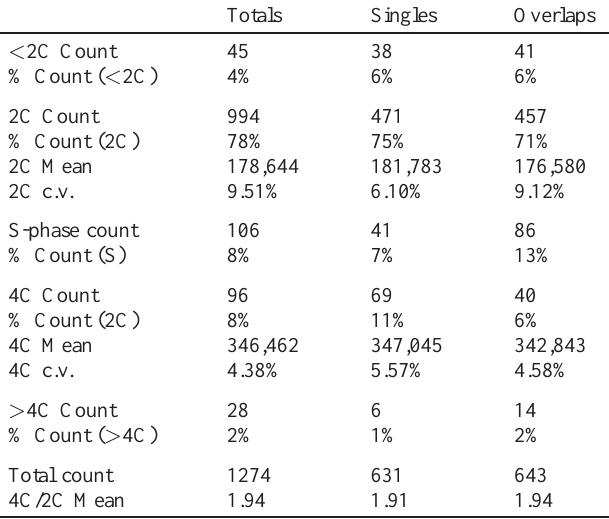
Fig. 4. Histogram of IOD values for all selected cell nuclei. Table 1 Summary statistics of ploidy